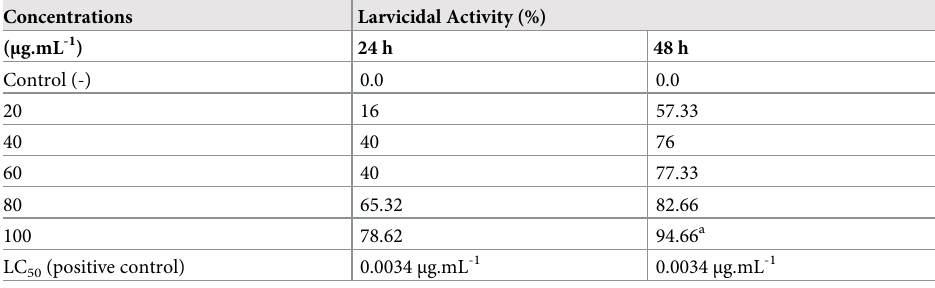
concentration. Table 2. Percentage of dead larvae (%) of A . aegypti L. produced by different concentrations of O . majorana L. essential oil in 24–48 h.